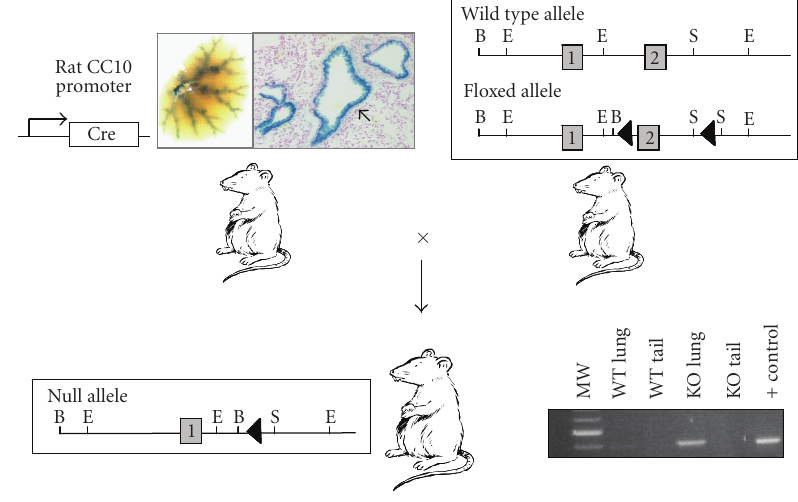
Figure 2: The generation of conditionally targeted epithelial cell PPAR γ deficient mice [85]. We developed a line of mice capable of targeting the airway epithelium by expressing Cre recombinase under the direction of the rat CC10 promoter (top, left). These mice, termed CCtCre, were crossed with the ROSA26 Cre reporter mouse to test the e ffi ciency for recombining loxP sites in vivo which demonstrated β -galactosidase staining limited to the conducting airway epithelium (arrow within inset). We crossed the CCtCre mice with mice homozygous for a PPAR γ allele with a pair of loxP sites flanking exon 2 of the gene (top, right) [100], creating mice with PPAR γ deficiency limited to the conducting airway epithelium (bottom, left). The conditional targeted genotype was confirmed by identification of gene rearrangement specifically in the lung alone (bottom,